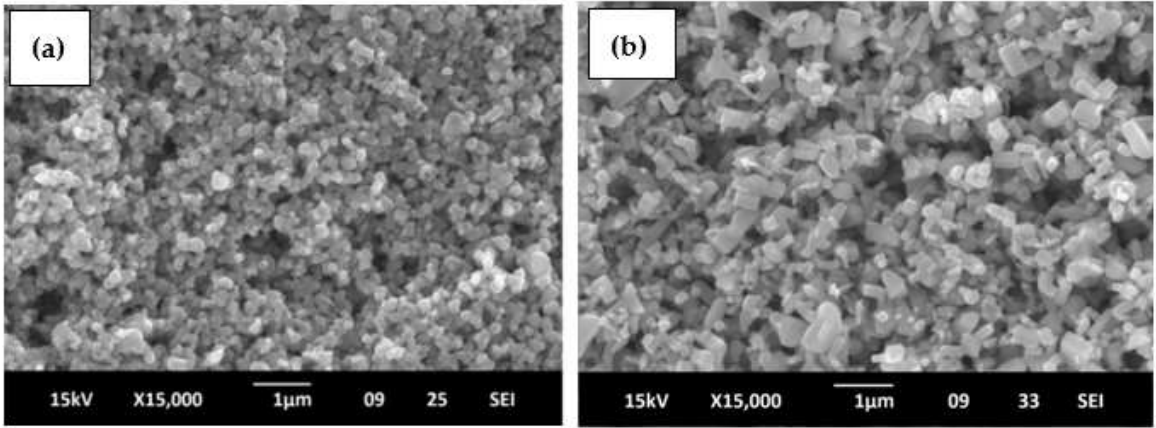
Figure 7. Surface morphology of SEM for ( a ) TiO2 and ( b ) ZnO [20].